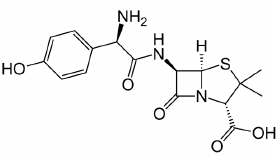
Figure 1. Chemical structure of amoxicillin (Amox).